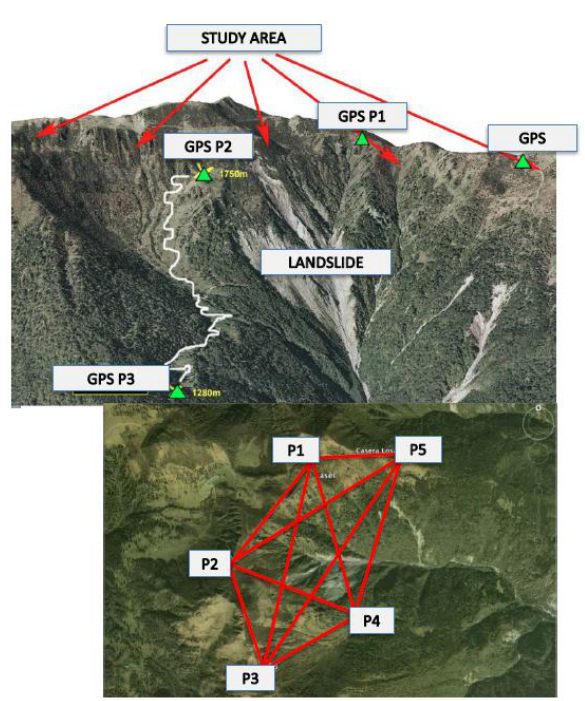
Figure 2. The five GPS